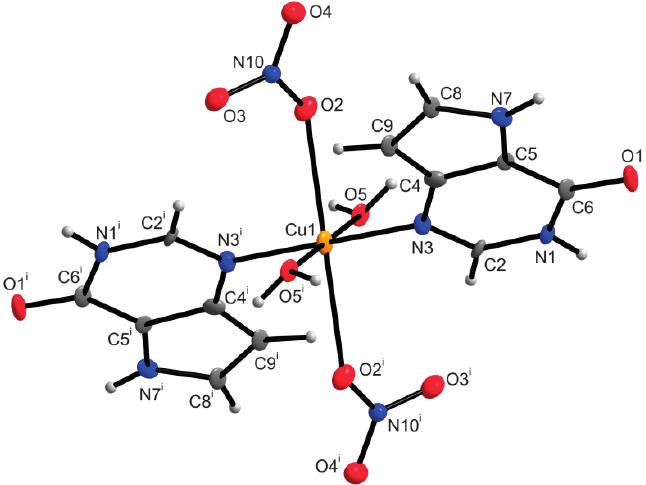
Figure 4. The molecular structure of complex 2a , together with the atom numbering scheme. Only one of two crystallographically independent molecules of [Cu(9dhx) 2 (H 2 O) 2 (NO 3 ) 2